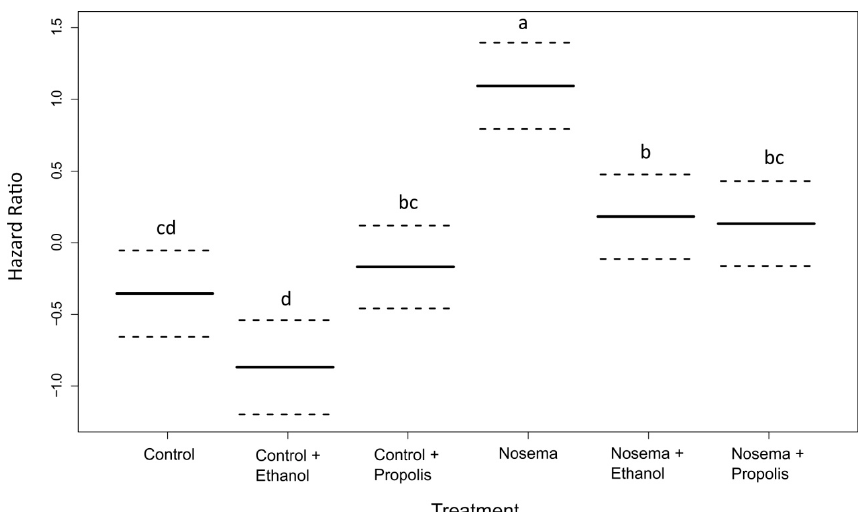
Figure 1. Survival of caged and experimentally treated honey bees ( Apis mellifera ): Control, Control + Ethanol, Control + Propolis, Nosema, Nosema + Ethanol and Nosema + Propolis.